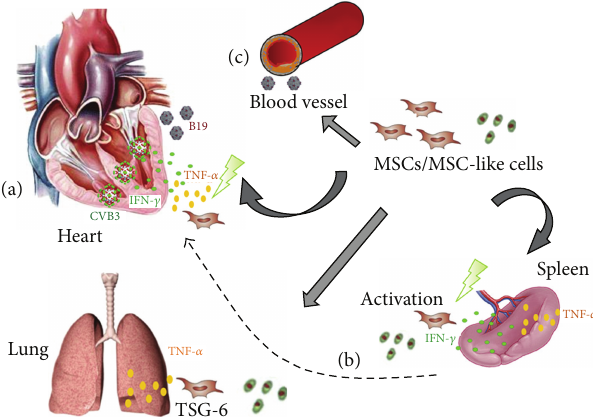
Figure 2: Hypothetical scheme representing how the cardiac out- come in inflammatory cardiomyopathy may be influenced after i.v. injection of MSCs or the MSC-like CardAPs. Via (a) direct cardioprotective effects, via (b) extracardiac immunomodulatory effects involving MSCs/CardAPs-mediated immunomodulation in the spleen and/or other secondary lymphoid organs, and the induc- tion of tumor necrosis factor-stimulated gene- (TSG-) 6 expression by human MSCs/CardAPs upon engraftment, for example, in the lung, and via (c) systemic endothelial-protective effects. The contribution of (a), (b), or (c) on the final cardiac outcome is expected to depend on the kind of inflammatory cardiomyopathy, be it viral- (CVB3 or B19-induced) or nonviral-